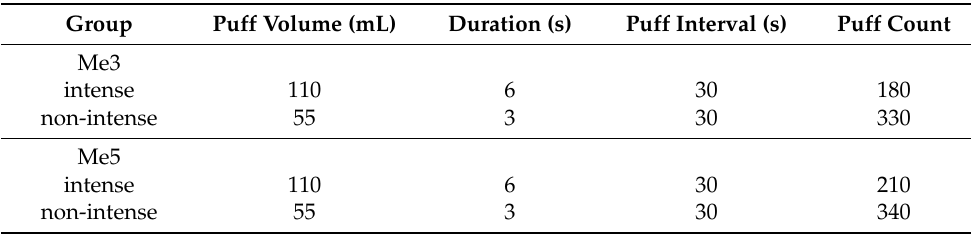
Table 2. Parameters of aerosolization.